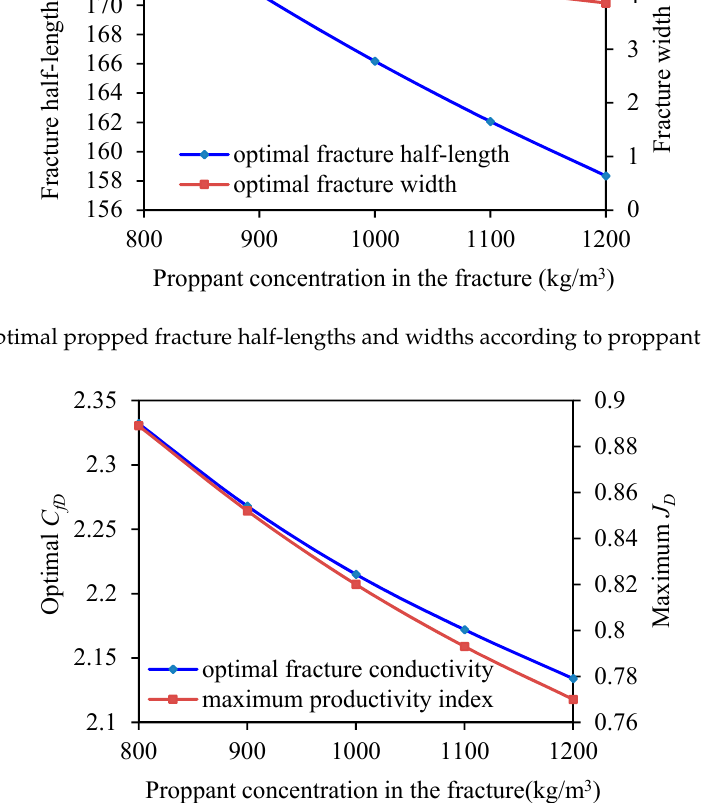
Figure 16. Optimal values of (cid:1829) (cid:3033)(cid:3005) and maximum (cid:1836) (cid:3005) according to proppant concentration